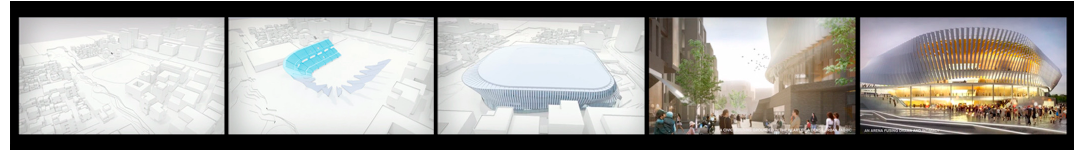
Figure 9. C.F. Møllers, Suggestion to Copenhagen Arena. Movie by C.F. Møllers (3:54),